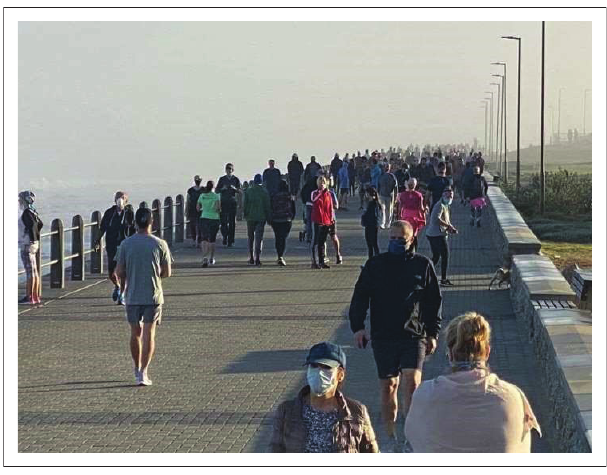
FIGURE 1: Exercise on Sea Point Promenade, Cape Town, during lockdown level